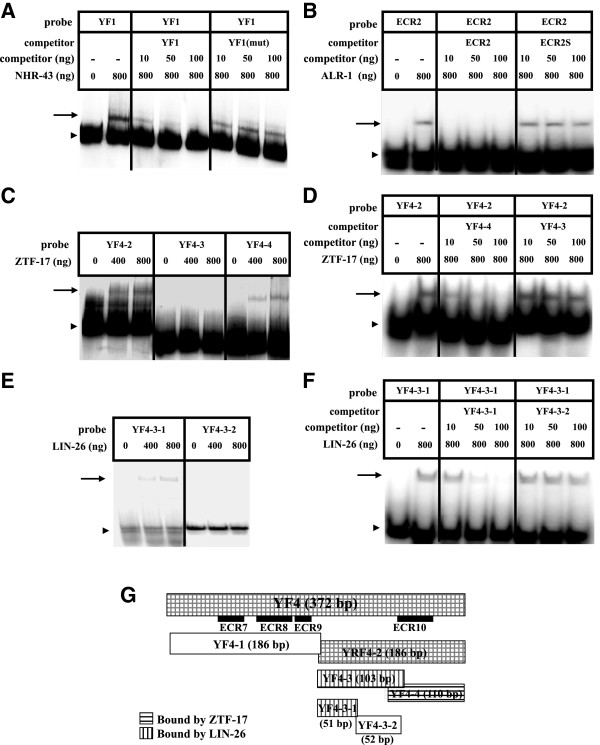
LIN-39 regulators identified in yeast bind to lin-39 promoter regions in vitro. A - F) Gel mobility shift assays with proteins expressed and purified from E. coli. Arrowhead indicates free probe; arrow indicates protein DNA complexes. For each panel, the top line identifies the labeled probe used, the bottom line shows the amount of protein added in each lane; middle lines (panels A, B, D and F) indicate the identity and amount of competitor added. A) NHR-43 binds to YF1 (342 bp). Lanes 3–5 contain cold wild type YF1 as competitor, while lanes 6–8 contain cold YF1 with the TGAC site mutated as competitor; B) ALR-1 binds to ECR2 (40 bp); this binding is competed by wild type ECR2 but not by a scrambled oligonucleotide with the same nucleotide composition (ECR2S); C) ZTF-17 binds to YF4-2 (186 bp) and YF4-4 (110 bp); D) ZTF-17 binding to YF4-2 is competed by YF4-4 but not YF4-3; E) LIN-26 binds to YF4-3-1 (51 bp); F) LIN-26 binding to YF4-3-1 is competed by YF4-3-1 (51 bp) but not YF4-3-2 (52 b); G) Fragment YF4 with ECRs 7–10 is shown above, with smaller subfragments diagrammed below. Shading indicates fragments that were bound by ZTF-17 and/or LIN-26 in yeast one-hybrid assays and in vitro.